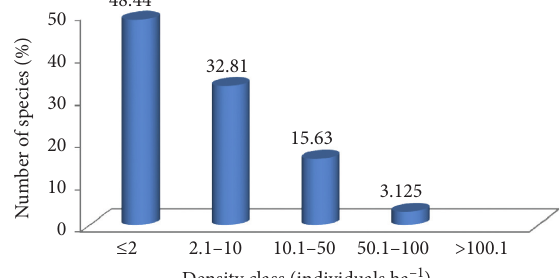
Figure 3: Density of all woody plant species by size class in Kafta Sheraro National Park.